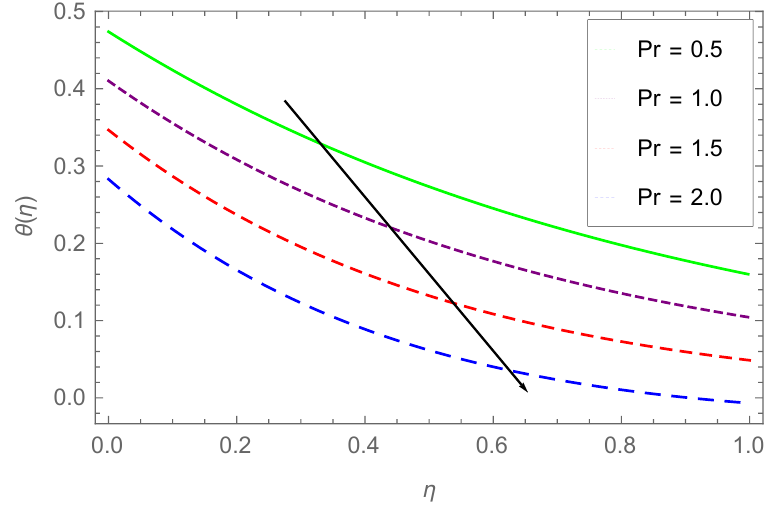
Figure 8. Variatiosn in θ ( η ) with differnt Pr